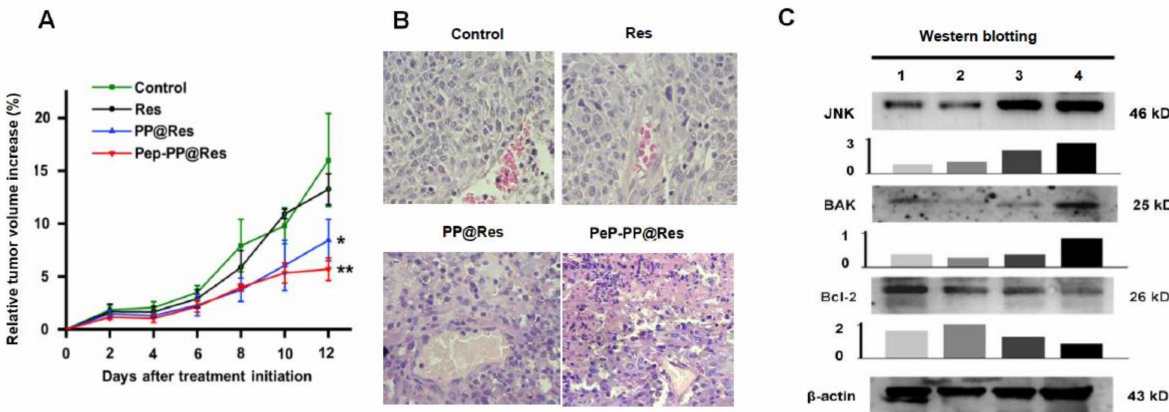
Figure 7. Pep-PP@Res inhibited growth and activated JNK signaling of the C6 xenografts in nude mice. ( A ) Relative tumor volume increase (%) after drug treatments. Note: * and ** indicate p -values < 0.05 and < 0.01 in comparison with the control group. ( B ) The morphology of tumor tissues in the four experimental groups and the extensive cell death in the Pep-PP@Res-treated tumor tissues; scale bar, 50 µ m. ( C ) Western blot examination of JNK signaling statuses in the C6 cells without drug treatment (1) and treated by free Res (2), PP@Res (3) and Pep-PP@Res (4). Grayscale analyses were conducted on the Western blot